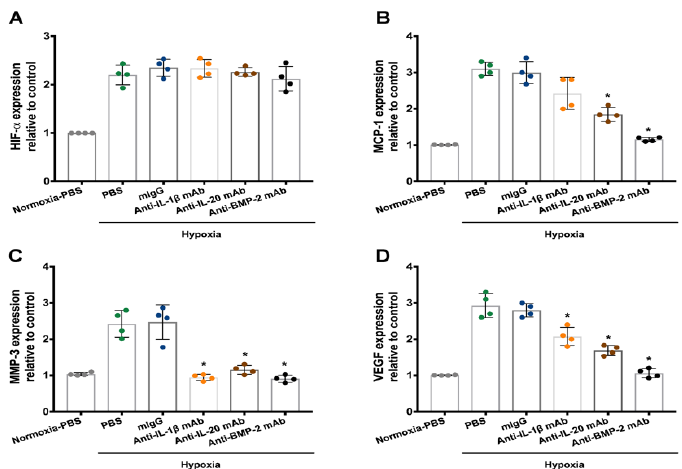
Figure 3. The effects of anti-IL-1 β , -IL-20, and -BMP-2 mAb in IVD cells under hypoxia. IVD cells were exposed to PBS, mIgG (2 µ g / mL), IL-1 β antibody (2 µ g / mL), IL-20 antibody (2 µ g / mL), and BMP-2 antibody (2 µ g / mL) under hypoxic conditions for six hours ( n = 4 / group). ( A – D ) The expression levels of indicated genes were analyzed using RT-qPCR with specific primers. β -actin was an internal control. Dots on the bar chart indicated the quadruplicates for each group. * p < 0.05 compared with mIgG-treated controls. Data are expressed as mean ± SD and are representative of three independent experiments.